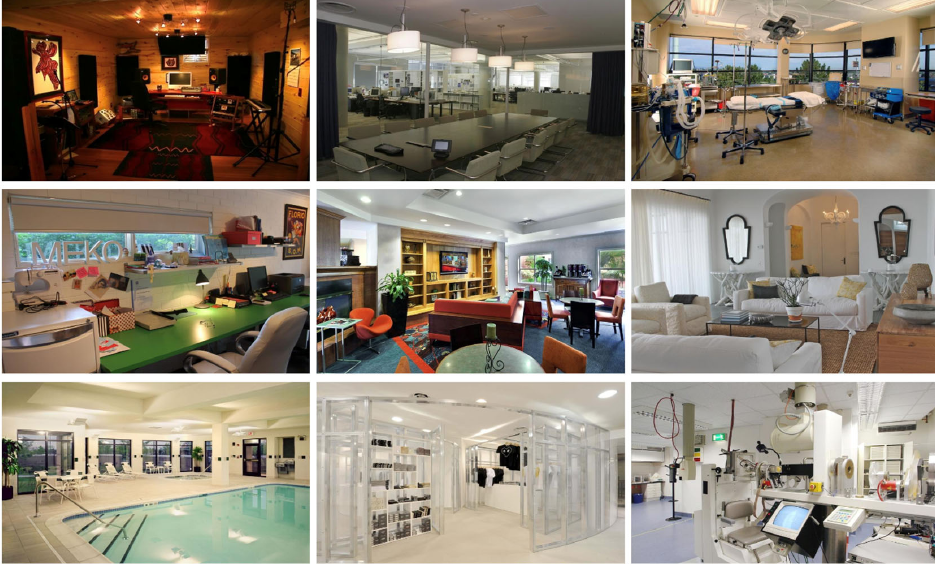
Figure 2. Some of the images of interior environments used in the experiment.